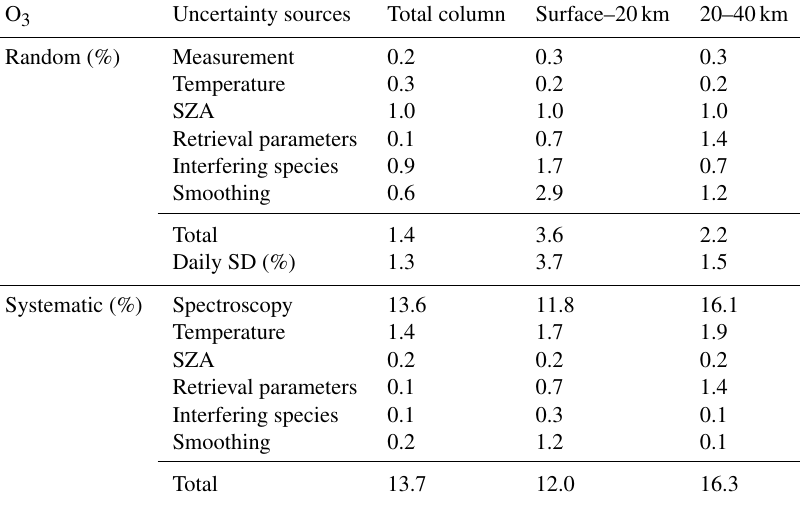
Table 2. The estimated retrieval uncertainty of the retrieved O 3 total column and two partial columns at Xianghe, together with the corre- sponding means of the daily SD of the FTIR O 3